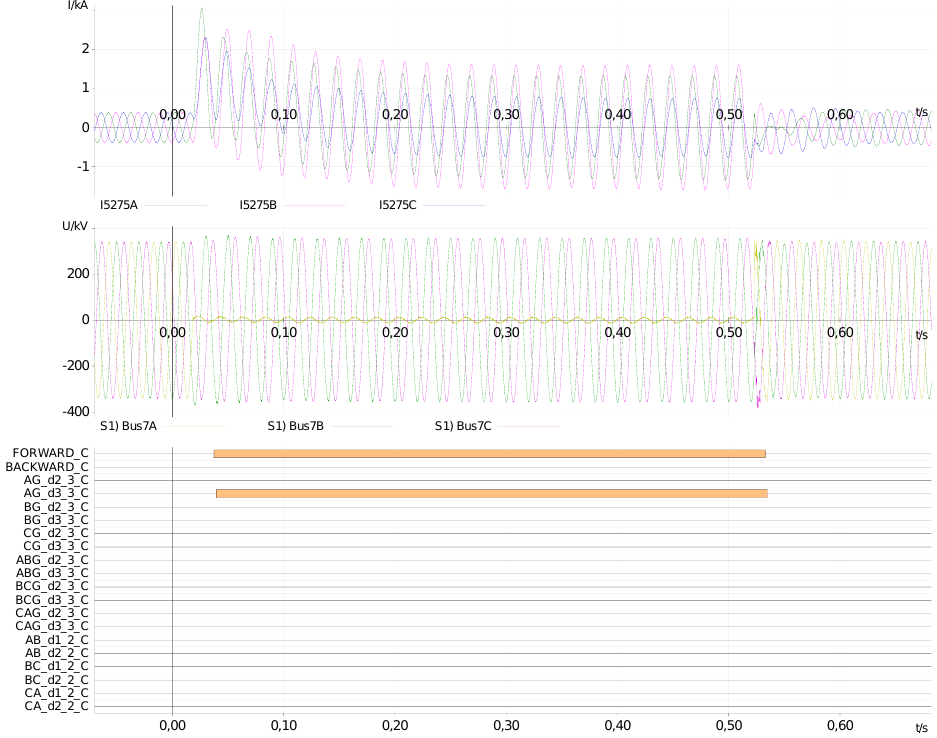
Figure 15. Phase A to ground fault, R = 0 ohm, Generation = 200 MW, Point of the line = 70%.